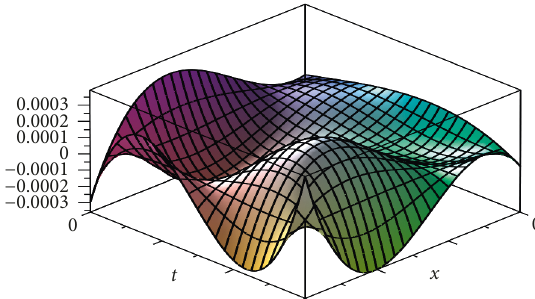
Figure 2: The approximate solution of u